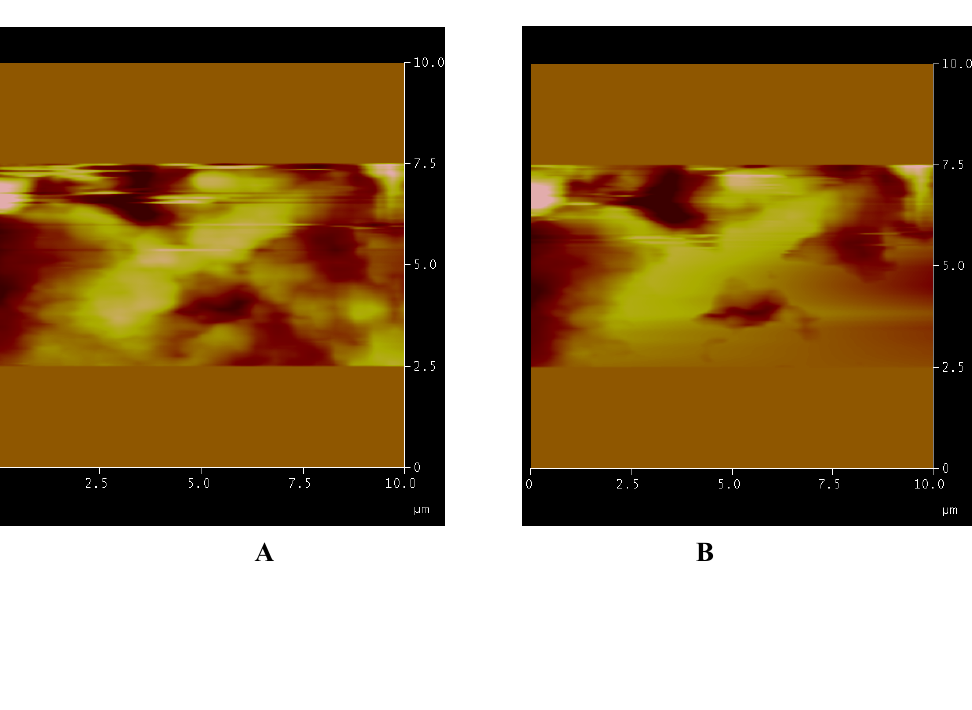
Figure 3. Solvent effect. The sequence of images shows the scanned area at full scale of 10 µm and its respective morphological structures ( A ); the advancing solvent front ( B – D ); the surface completely covered ( E ) and after evaporation ( F ). In G is shown the preservation of surface and its relative structures. In H is shown the picture with respective processed data during a single